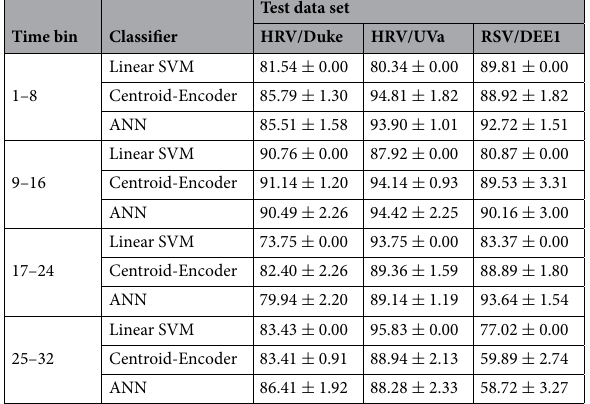
Table 3. Balanced success rate (BSR) of LOSO testing on three test studies using Feature Set 1. Data is normalized using Limma on Subject ID.